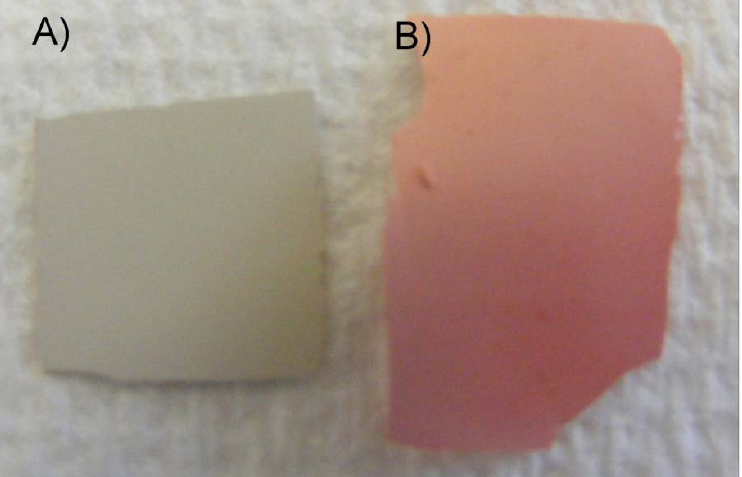
Figure 1. ( A ) Bare nanoporous ZnO electrode. ( B ) CdTe coated ZnO electrode. Quantum Dots (QDs) have been synthesised in aqueous solution with MPA